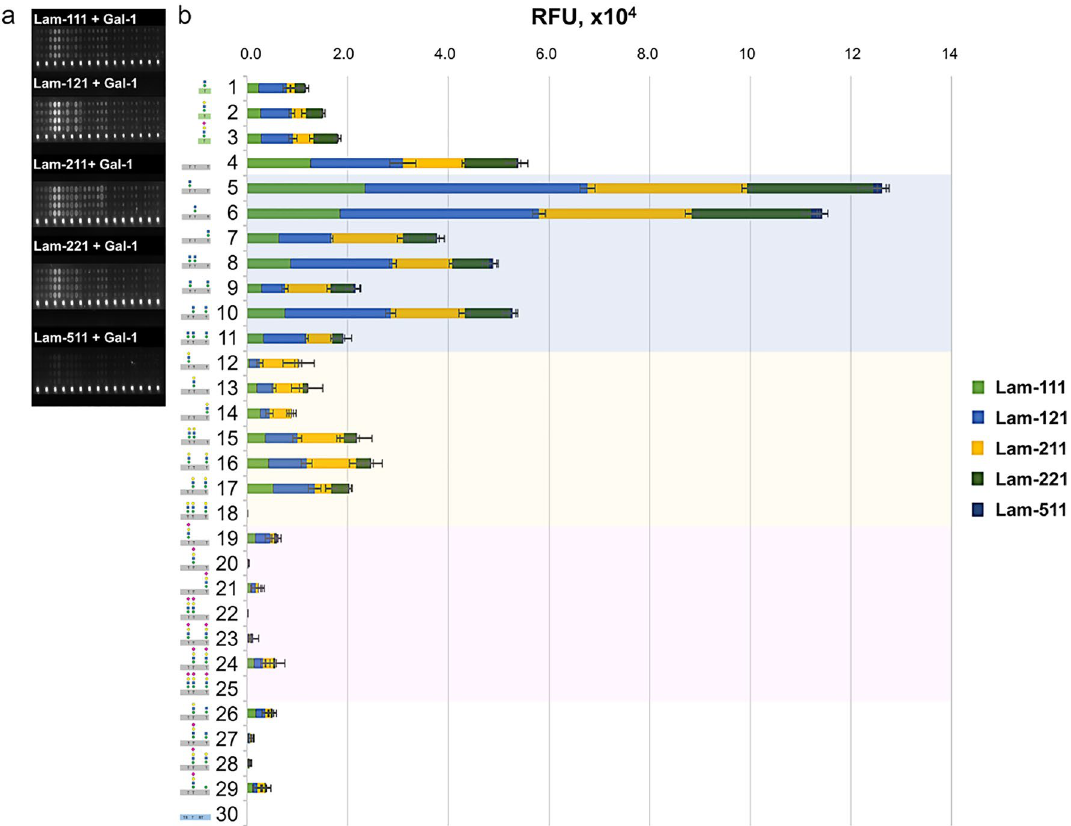
Figure 8. Fluorescence image of microarray chip ( a ) and stacked chart of signal intensities ( b ) of 200 μM core M1 α-DG glycoconjugates taken after treatment with 32.0 μg/mL Cy3-laminin–unlabeled-Gal-1 solution for 30 min. The relative interaction of 200 μM α-DG unglycosylated peptides with 0.10 μg/mL to 32.0 μg/mL Cy3- laminin–unlabeled-Gal-1 solution is in Supplementary Fig.